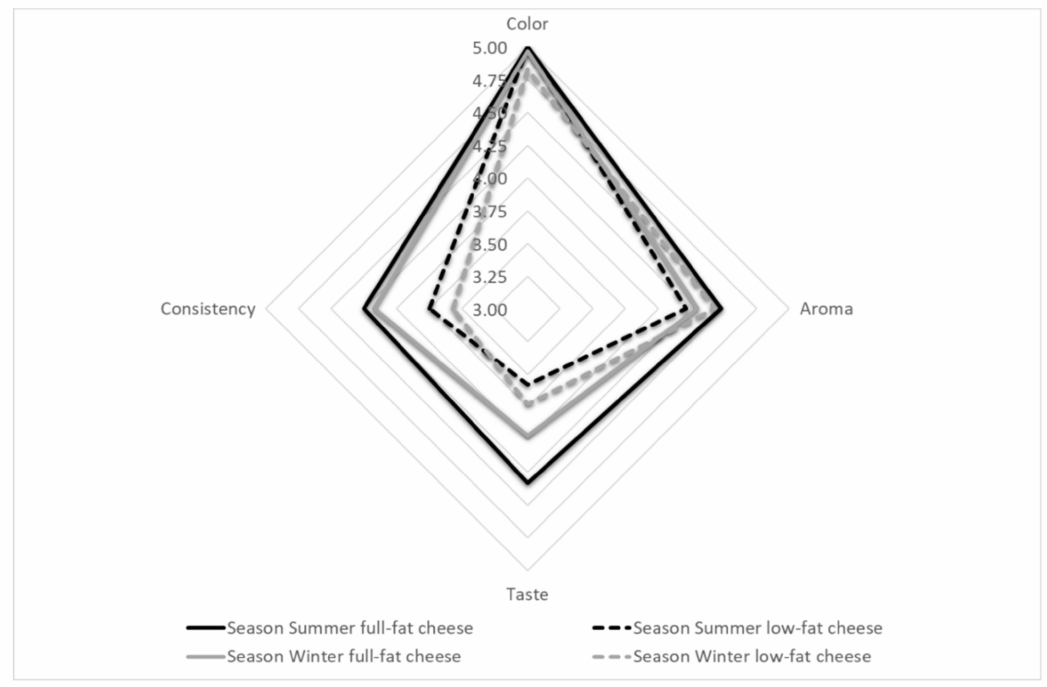
Figure 1. Organoleptic assessment of the cheeses